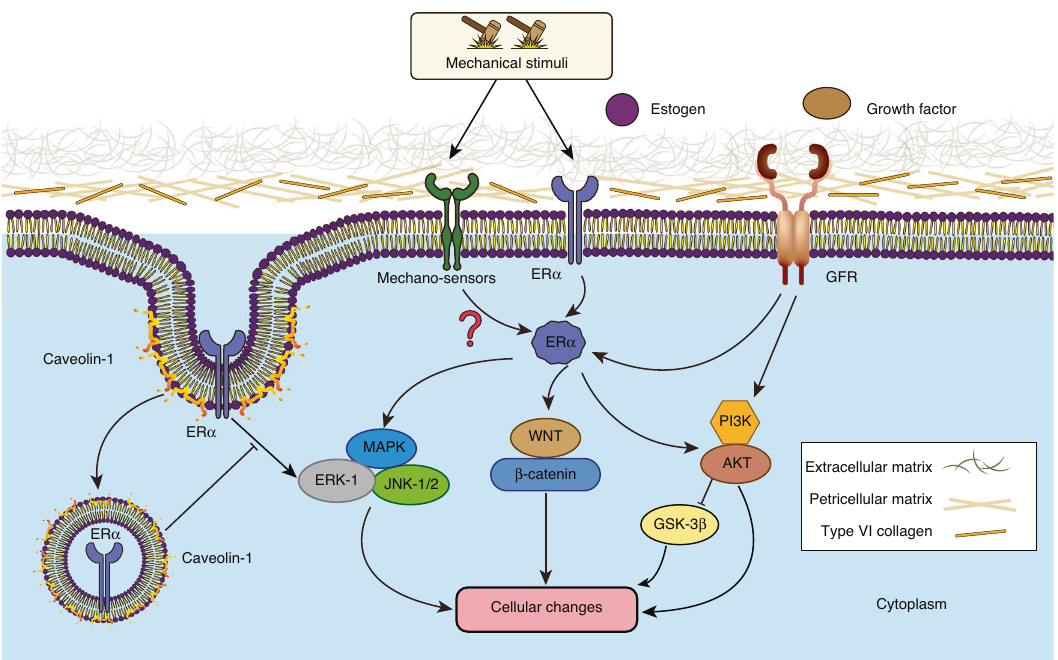
Fig. 5 Potential targets that are regulated by ER α mediating chondrocyte responses to mechanical stimulation. Pointed arrows indicate stimulatory effects, and blocked lines indicate inhibitory effects. Some proposed pathways and interactions in chondrocytes remain to be determined. ER α : estrogen receptor α , MAPK: mitogen-activated protein kinase, ERK: extracellular signal-regulated kinase, JNK: c-Jun N- terminal kinase, GFR: growth factor receptor, PI3K: phosphatidylinositol-3-kinase, AKT: protein kinase B, and GSK-3 β : glycogen synthase kinase 3